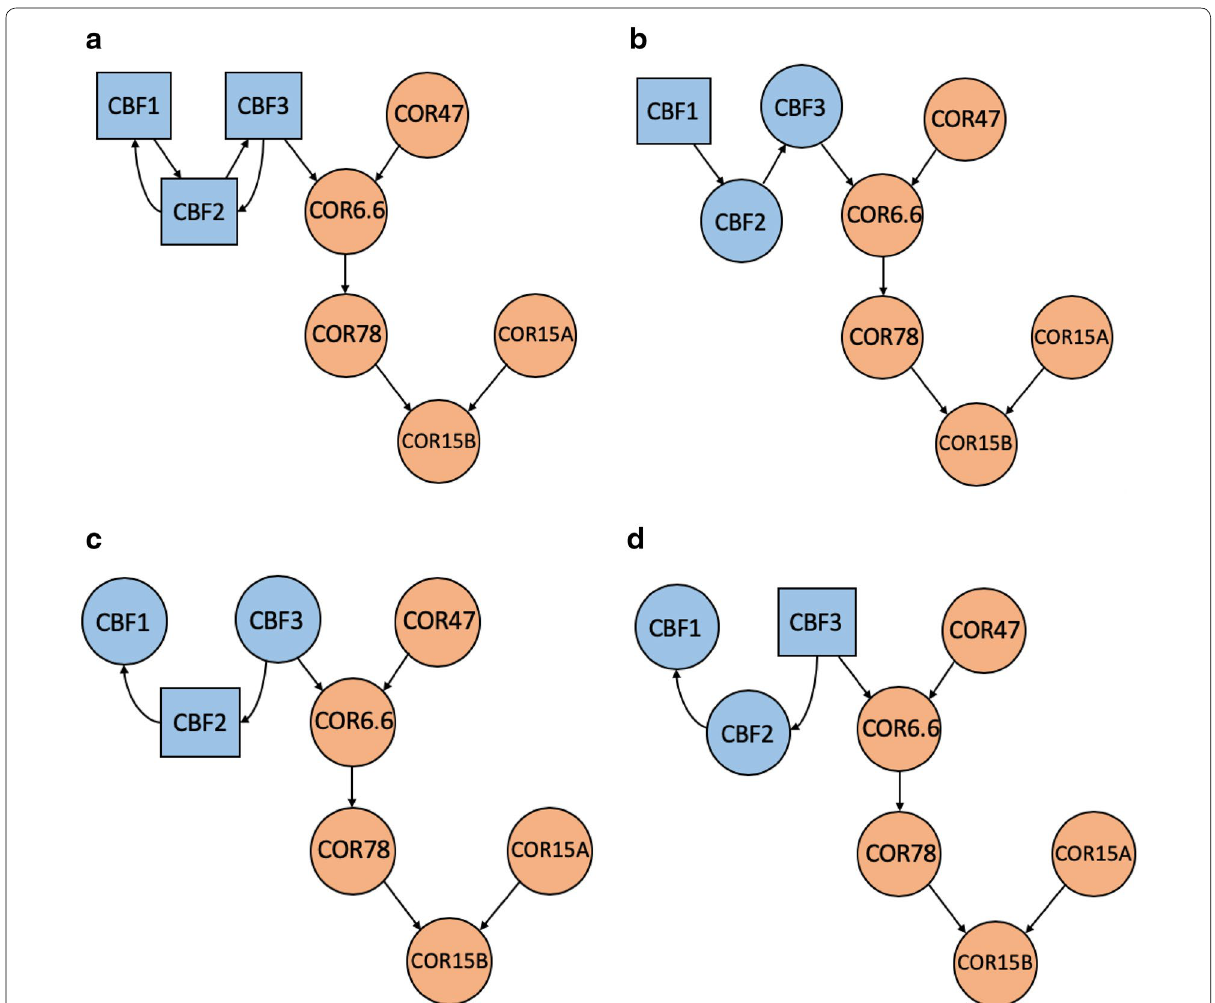
Fig. 4 The reconstructed paths from the source CBF genes (blue rectangles) to the target CBF genes (blue circles) or target COR genes (orange circles), respectively, starting from b CBF1 , c CBF2 , and d CBF3 . All the paths in b – d were combined to reconstruct the CBF‑COR GRN in